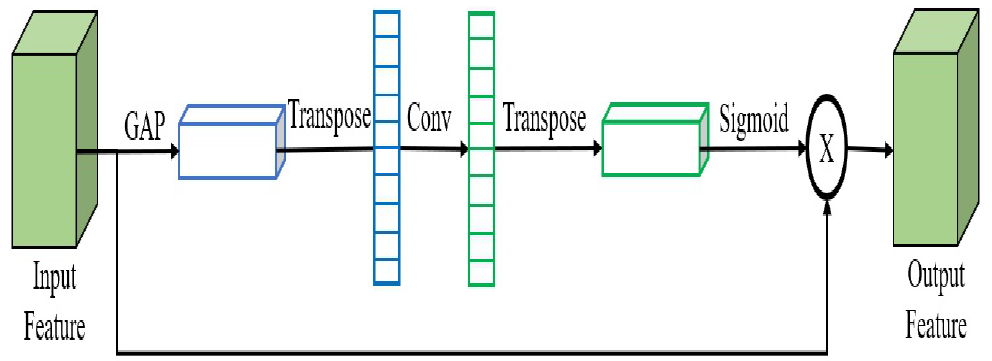
Figure 4. ECA attention